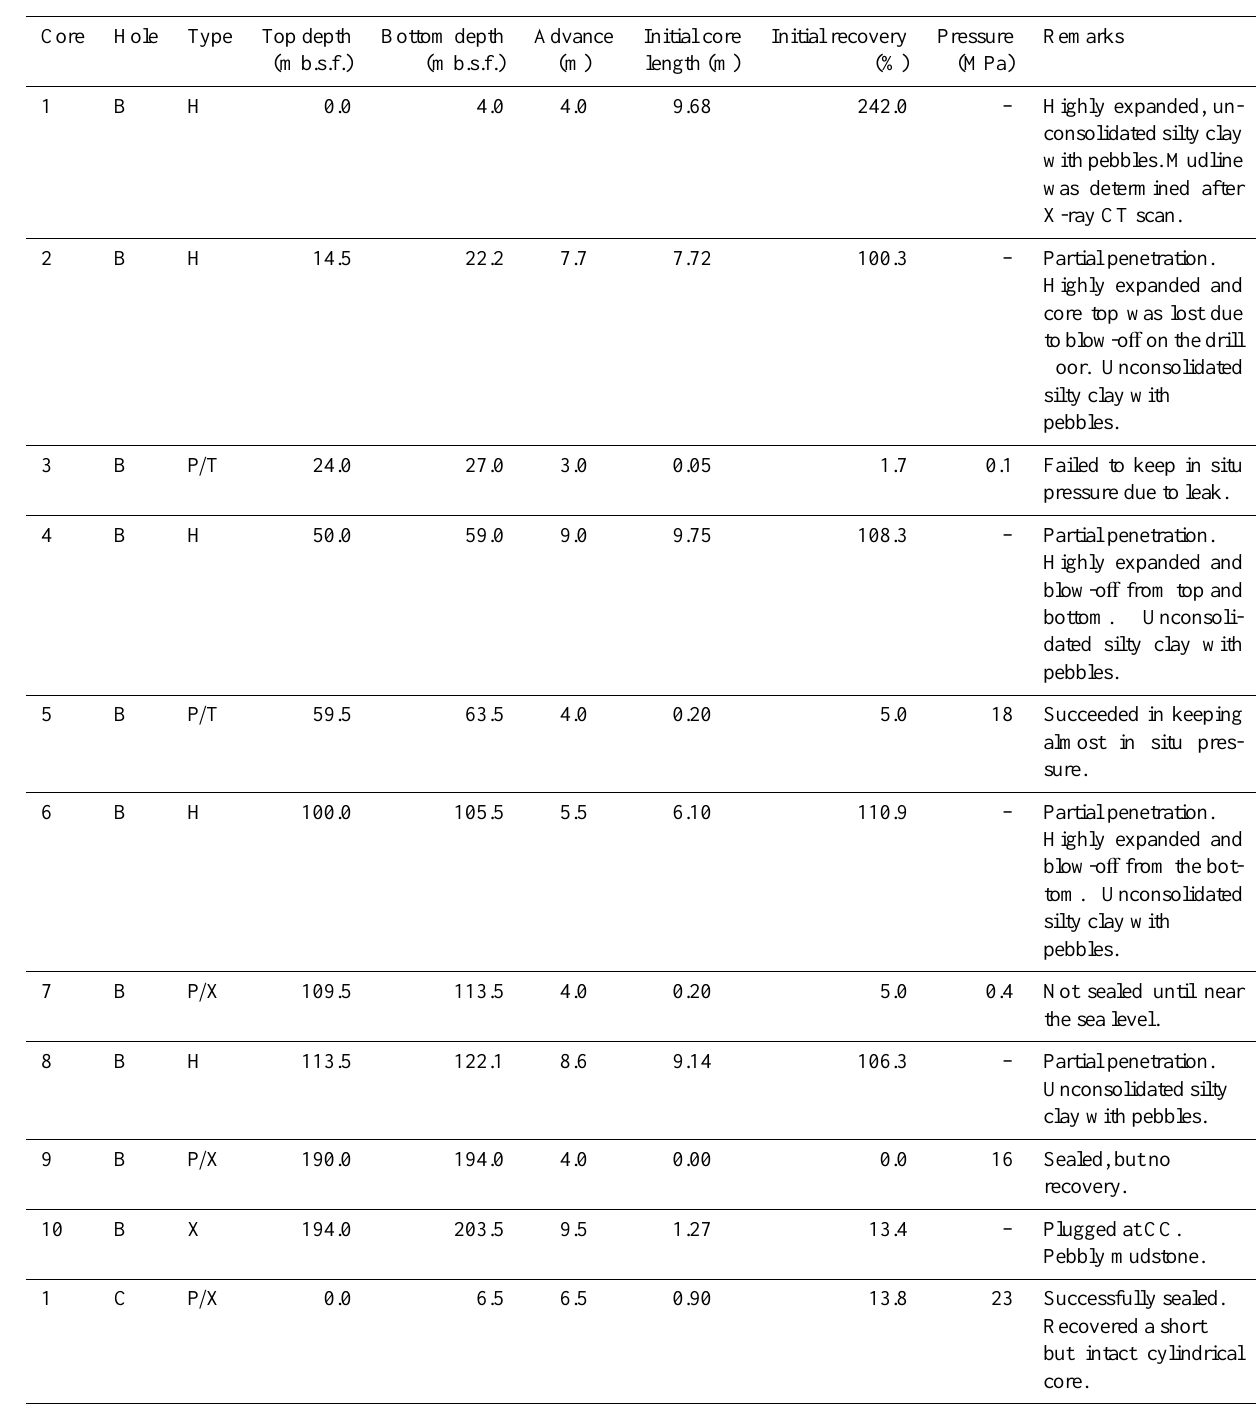
Table 2. Coring summary of expedition 906. H: hydraulic piston coring system, X: extended-shoe coring system, P / T: hybrid PCS with short extended shoe, P / X: hybrid PCS with long extended